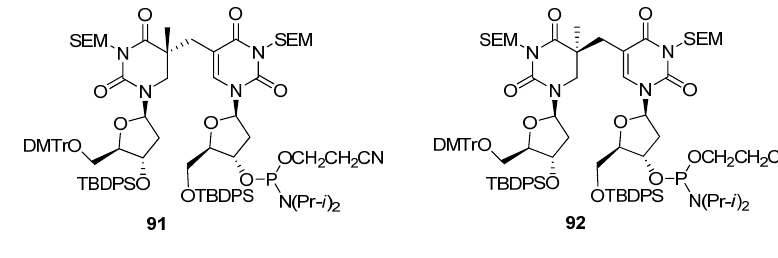
Figure 4. The structures of SP-amidite blocks 91 and 92 to prepare